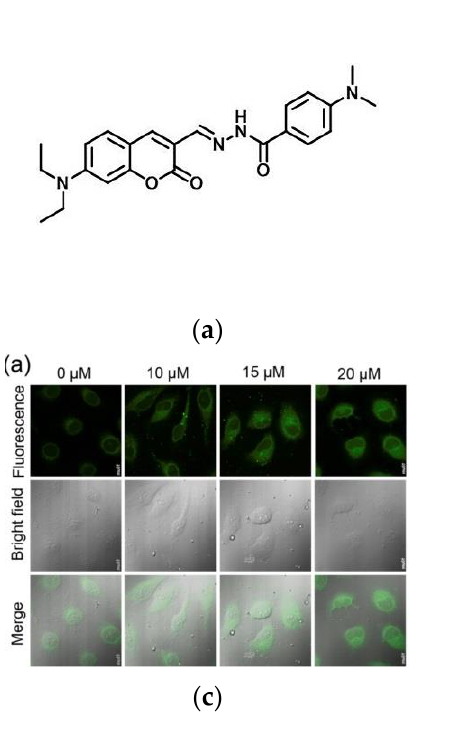
Figure 20. ( a ) Structure of probe HL; ( b )The fluorescence emission spectra of Cu 2+ -2H; ( c ) Confocal microscope images of MCF-7 cells. Reproduced with permission from [91]. Copyright 2020 Elsevier Ltd.